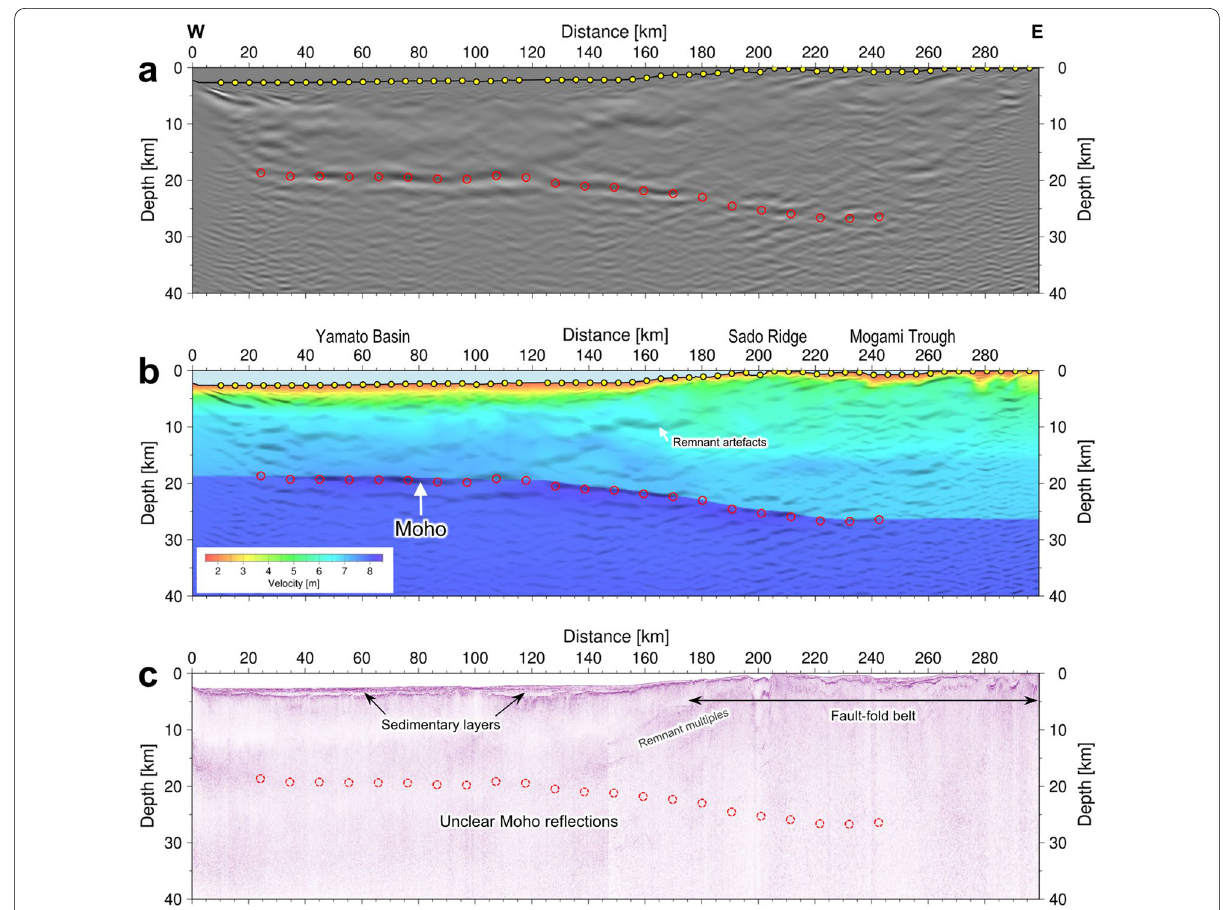
Fig. 3 Seismic profiles along line EMJS1003: a reflection profile obtained by RTM from airgun-OBS data in this study; b velocity model obtained by traveltime tomography (after Sato et al. 2014), and c depth-converted reflection profile of poststack migration from the multichannel seismic survey along the same line (after Sato et al. 2014). The yellow dots indicate OBS locations, and the red circles denote the probable Moho